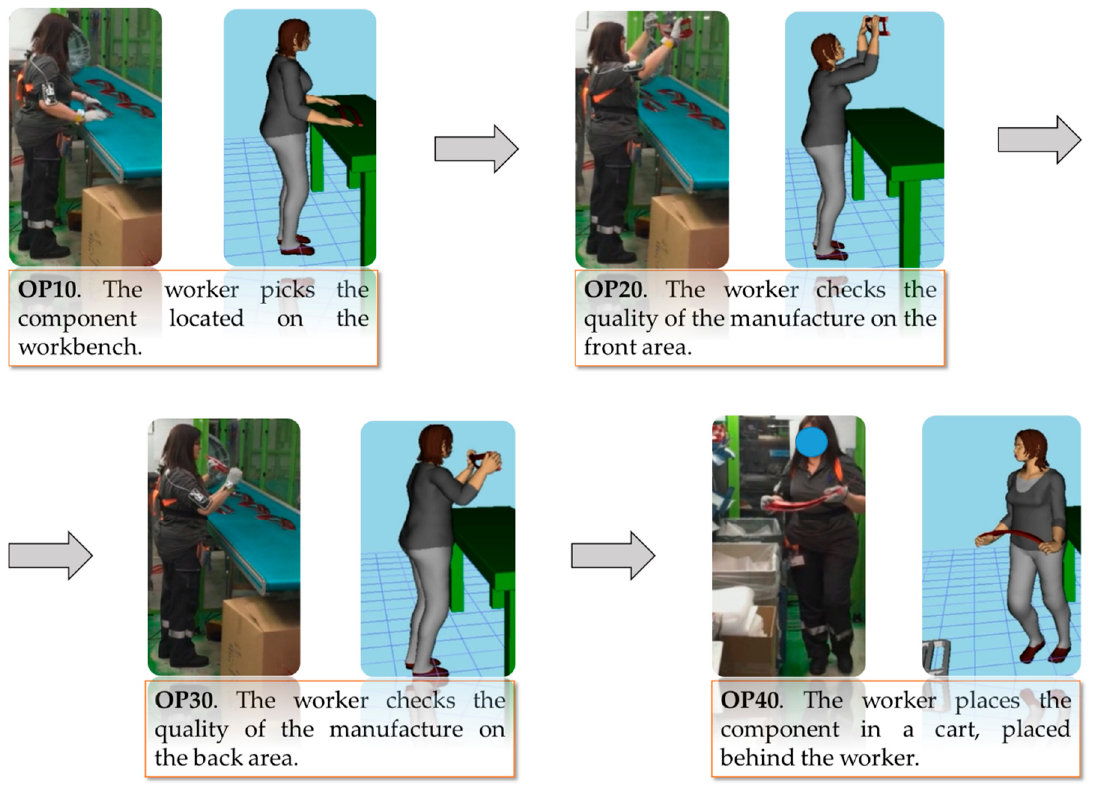
Figure 3. Tasks of the working activity. On the left is the real scenario and on the right is the Digital Twin.